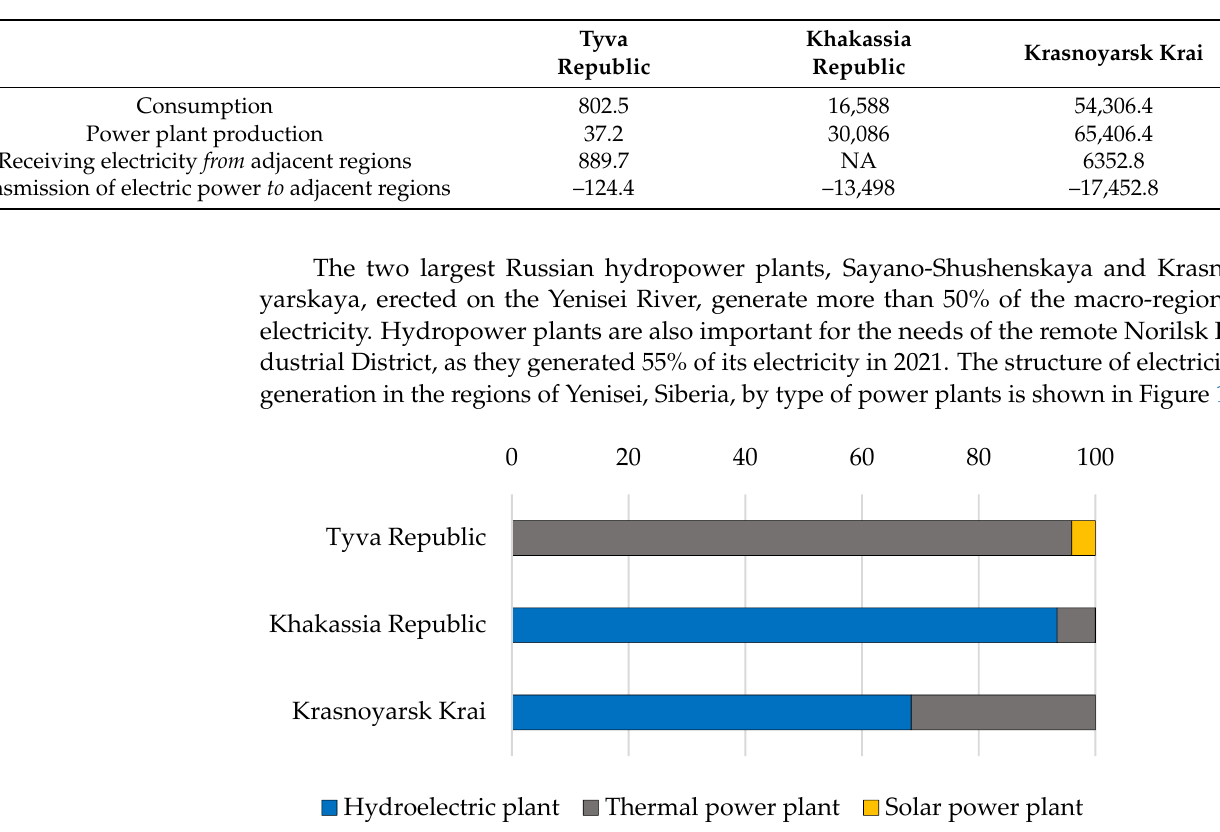
Table 1. The electricity balance of the energy systems of Yenisei, Siberia, in 2020 was one million kWh. Source: Schemes and Programs of Perspective Development of the Electric Power Industry of the Yenisei, Siberia, regions.